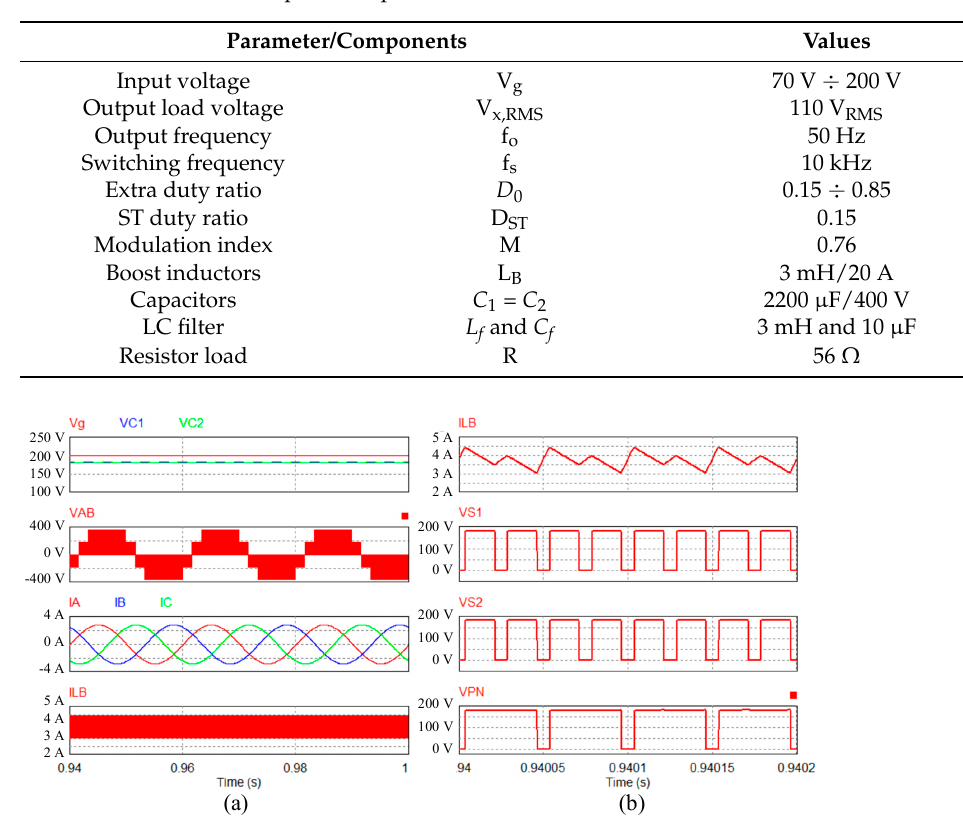
Table 3. Simulation and experiment parameters.